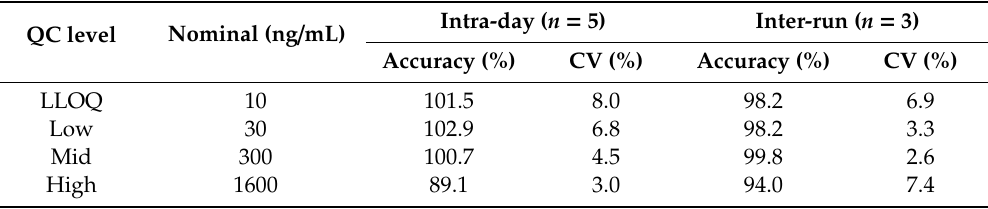
Table 1. Intra- and inter-day accuracy and precision for the determination of ATEC in rat plasma. QC, Quality Control, CV, LLOQ, lower limit of quantification.